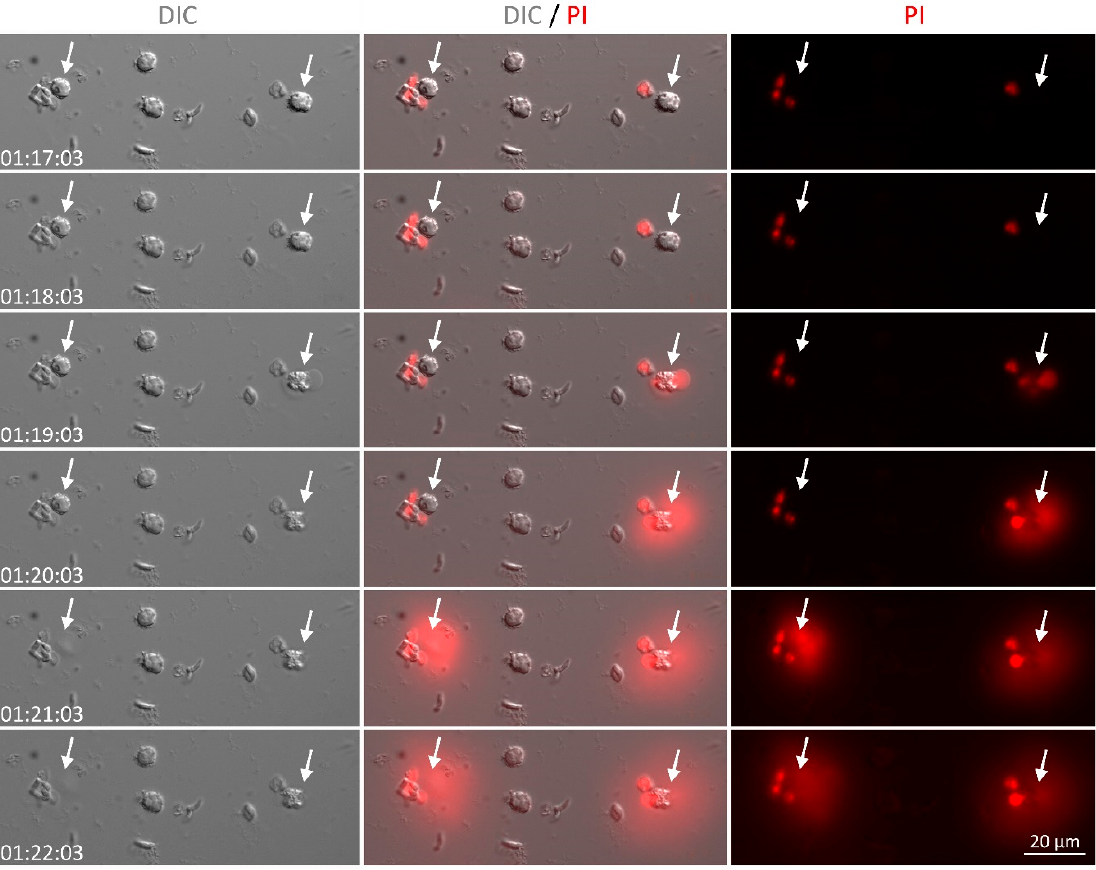
Figure 6. Time lapse recording of NET release by cat neutrophils in response to T. gondii . Neutrophils were stimulated with RH tachyzoites (5:1 parasites:neutrophil ratio) in the presence of propidium iodide (PI). Arrows point to neutrophils releasing NET after about 80 min of interaction with parasites. DIC = differential interference contrast.